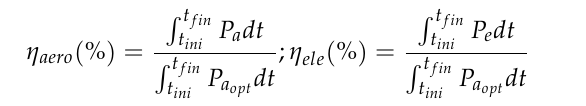
Figure 7. Rotor speed comparison for ISC, TISC, MISC and